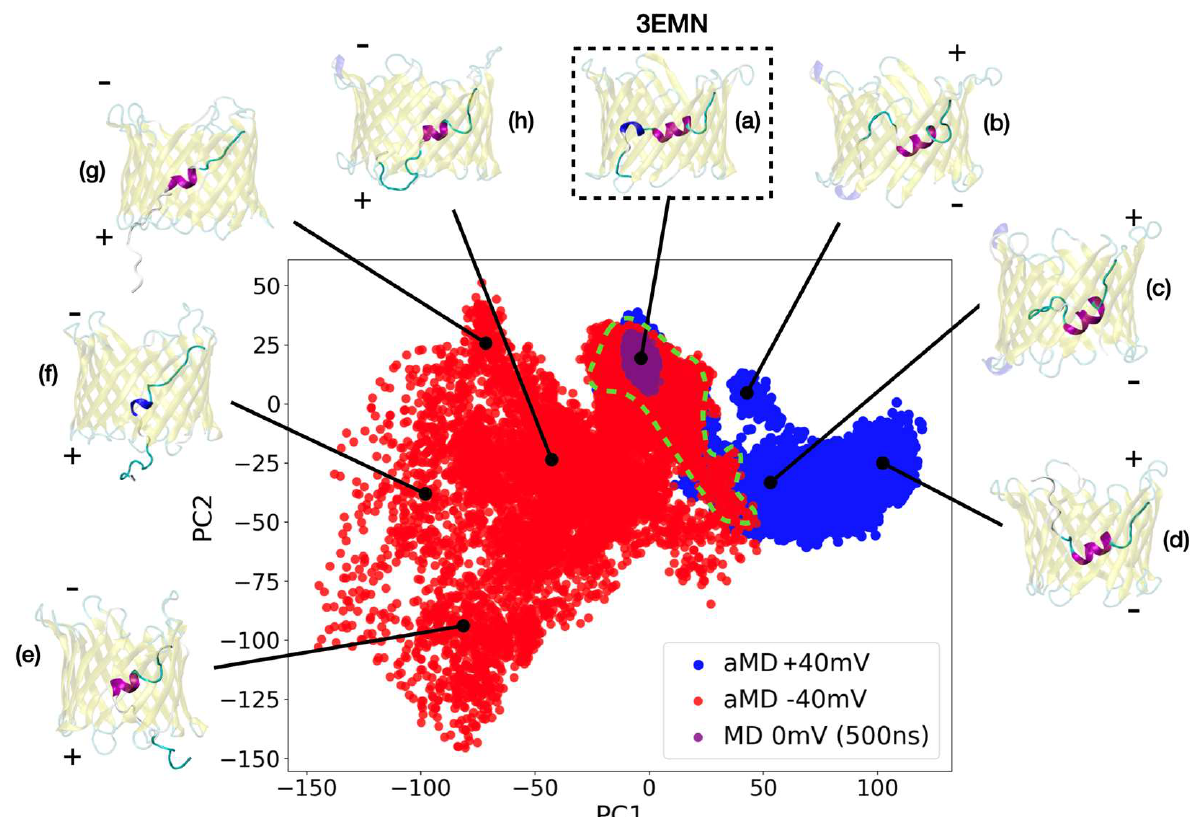
Figure 2. Conformational landscape of mVDAC1 sampled from aMD at +40 mV (blue) and at − 40 mV (red) (total simulation time at both voltages was 2 µ s). Conformations generated from unbiased MD over 500 ns are also shown (purple). Each conformer is given by its first two principal components computed from N-terminal atoms using all the aMD structures. The area delimited by the dashed green contour corresponds to the region of overlap between the two voltages. Representative structures of the different PC regions are also displayed. ( a ) Stands for the 3EMN crystal structure; ( b – d ) correspond to conformers generated at +40 mV while ( e – h ) represent conformers generated at − 40 mV.